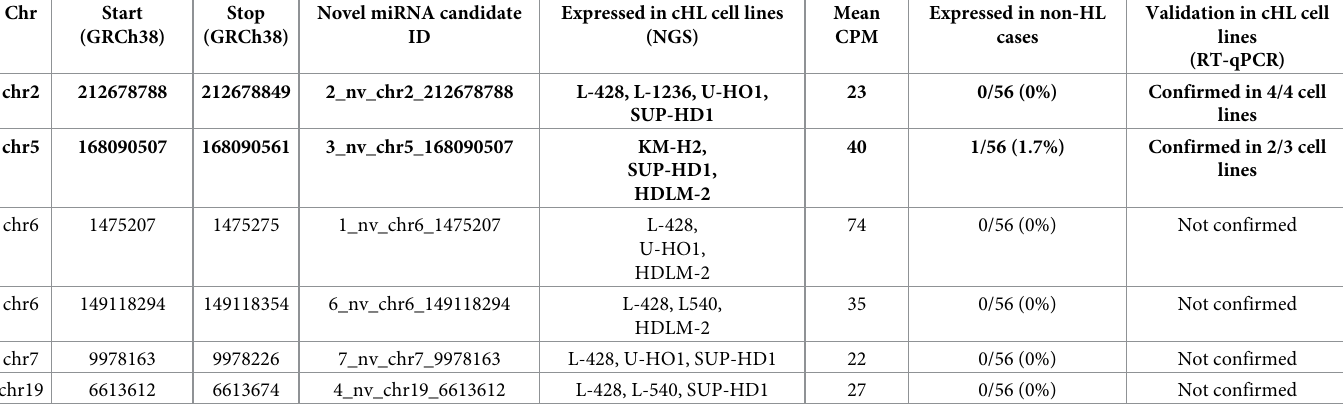
Table 1. Characterization of novel miRNA candidates. Expression of the bolded candidates was confirmed using RT-qPCR with TaqMan TM probes. Chr Start Stop (GRCh38)